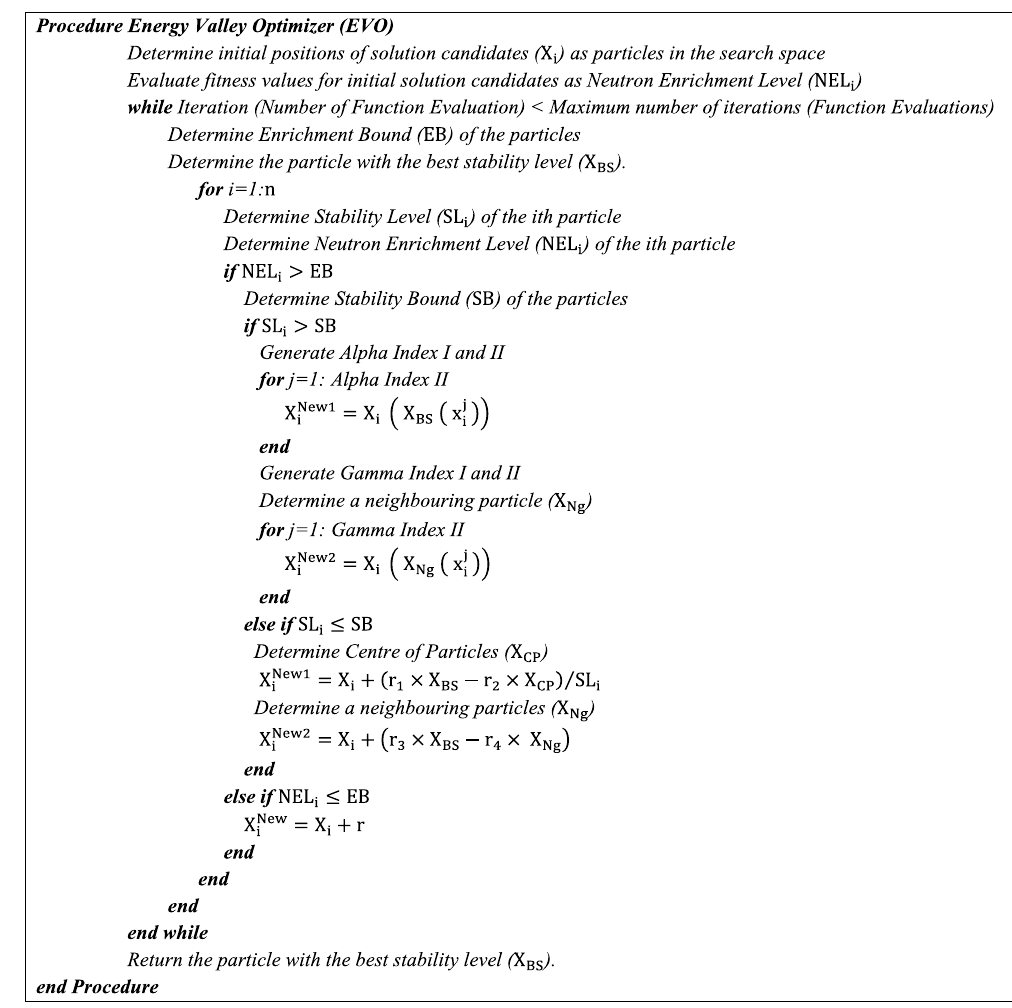
Figure 3. Pseudo-code of the